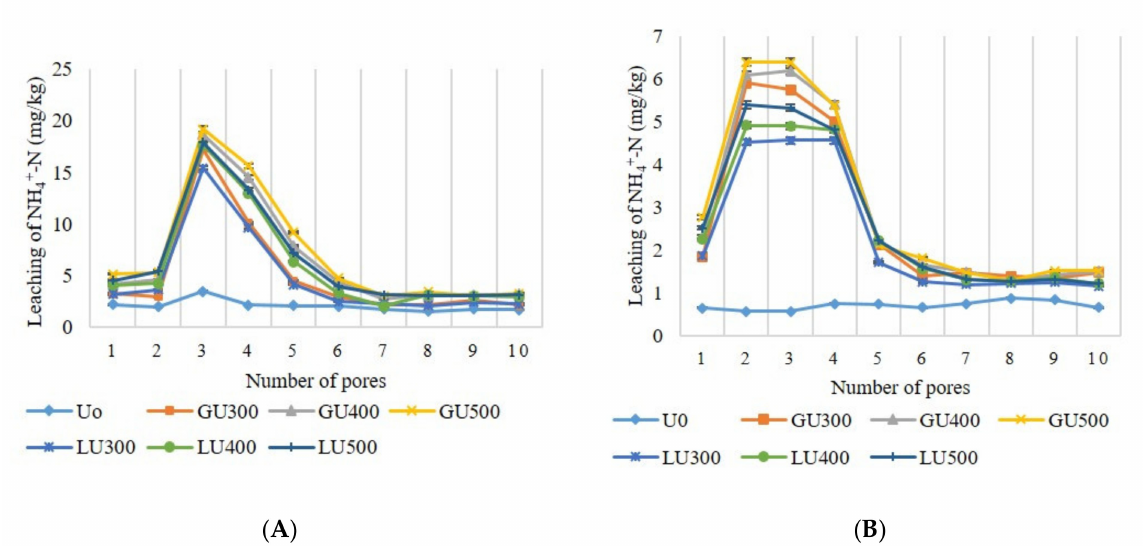
Figure 4. Leaching of NH 4+ -N (mg/kg) from Bungor ( A ) and Selangor ( B ) soils treated with different rate of LU and GU fertilizers in 10 pore volumes. Vertical bars on the graphs show the standard errors.